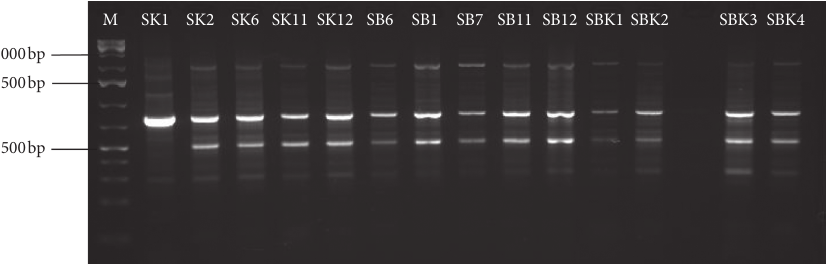
Figure 3: SRAP amplification profiles of mother plants and randomly selected in vitro regenerated of passion fruit of KPF 4 variety. Lane L is a 1 kb plus molecular weight DNA marker (Generuler, Thermo scientific); Lanes, SK1 and SK2, are plantlets micropropagated on MS+1mg · L − 1 KIN; SK6 is a plantlet micropropagated on MS+2 mg · L − 1 KIN; SK11 and SK12 are plantlets micropropagated on MS+3mg · L − 1 KIN; SB6 represents a mother plant; SB1 is a plantlet micropropagated on MS+1 mg · L − 1 BAP; SB7 is a plantlet micro- propagated on MS+2 mg · L − 1 BAP; SB11 and SB12 are plantlets regenerated on MS+3mg · L − 1 BAP; SBK1, SBK 2, and SBK 3 are plantlets micropropagated on MS supplemented with 2mg · L − 1 BAP +0.5mg · L − 1 KIN; SBK 4 represents a mother